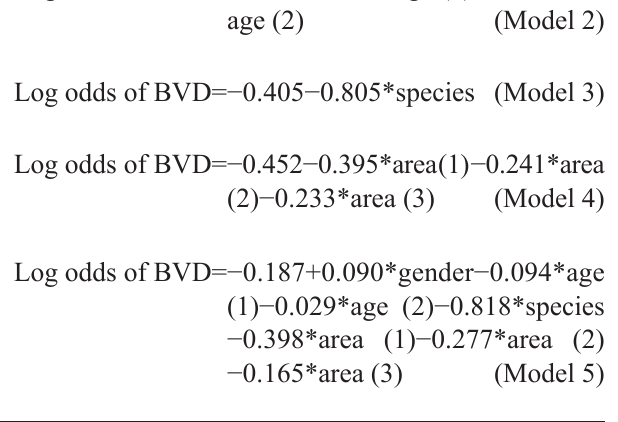
Chi-square test was done through the cross-tabulation (age * BVDV disease) option of SPSS using the original raw data of the individual cases. The test result denoted the value of Chi-square as 0.239 at df=2 along with the probability